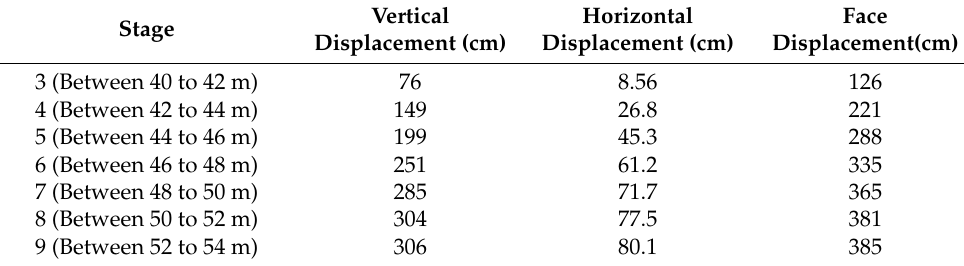
Table 5. Excavation stages.